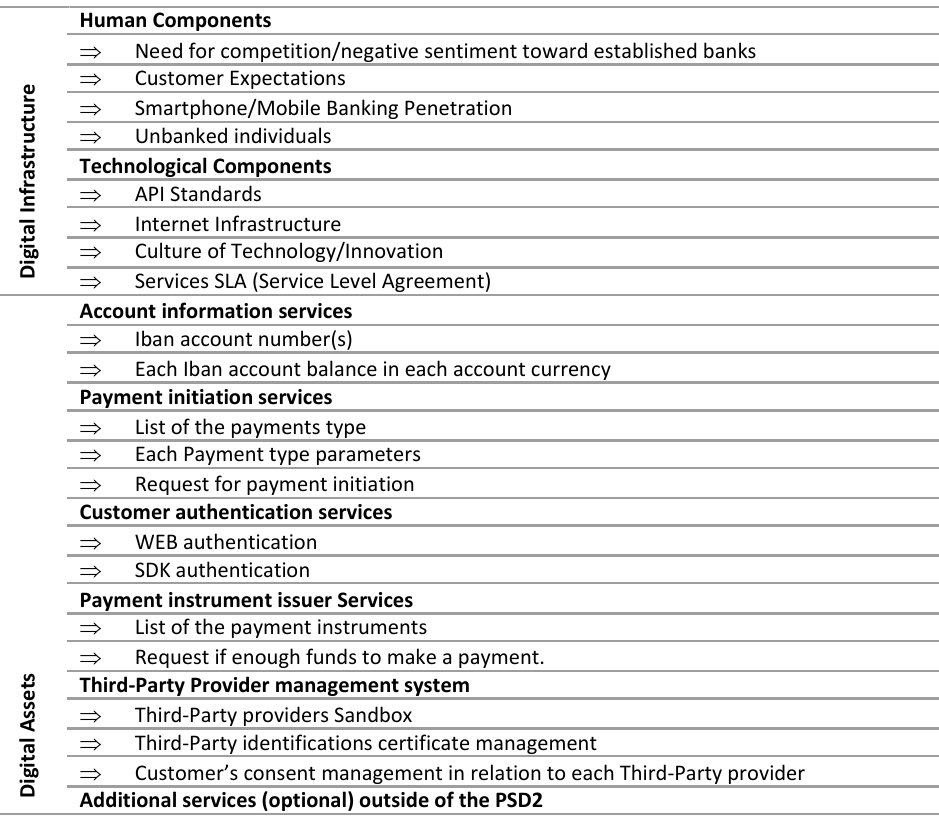
Figure 2. Elements of financial institution readiness for open banking. Source: generated by the au- thors.